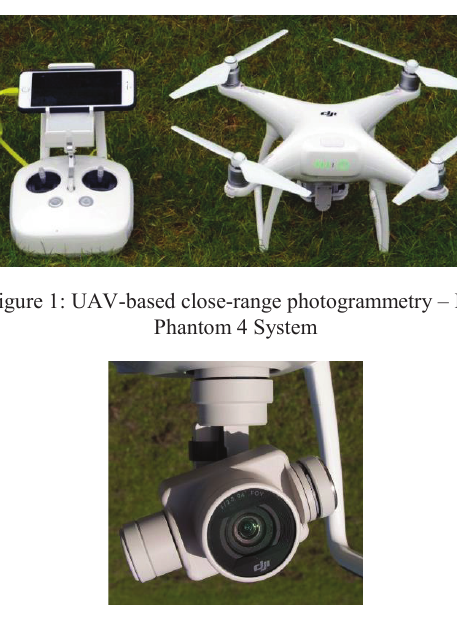
Figure 2: The DJI Phantom 4 digital camera 3.2 Digital processing and output visualization of UAV-